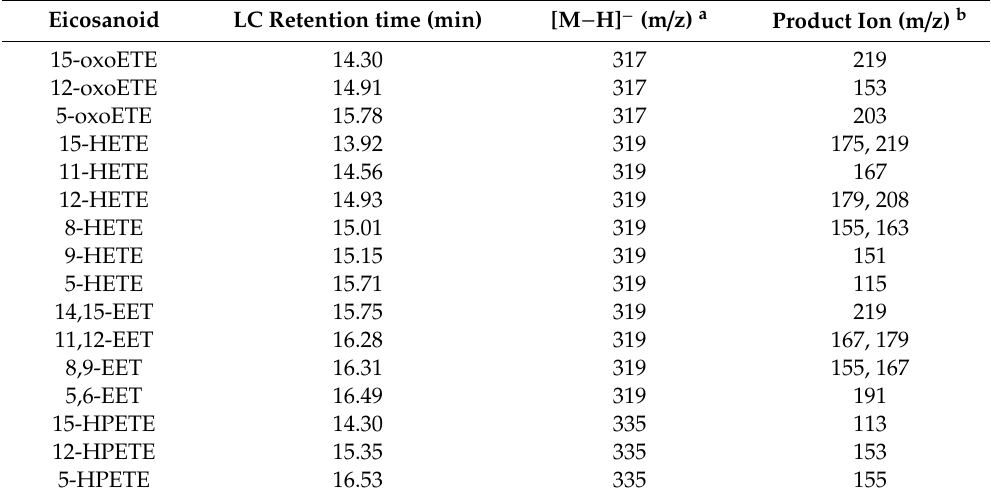
Table 1. Products of AA detected in commercial samples of the fatty acid.